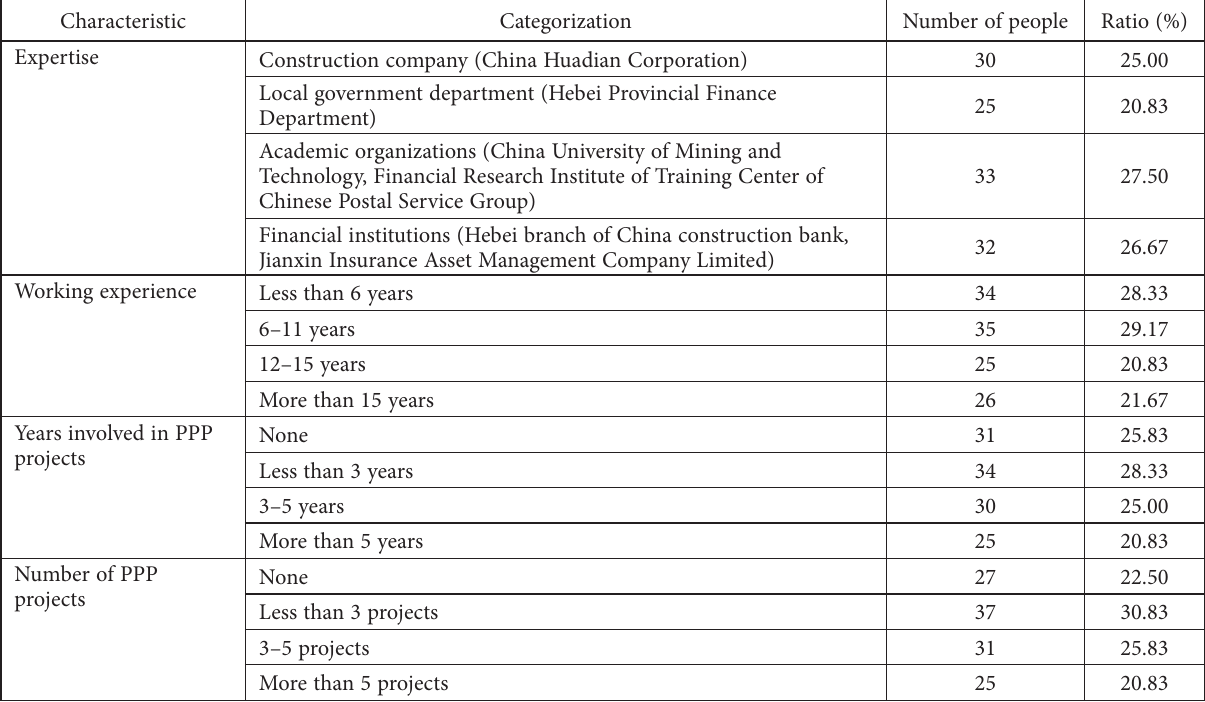
Table 2. Survey respondent